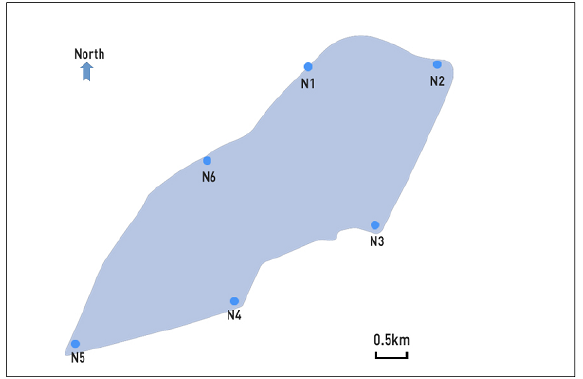
Figure 1. Distribution of sampling sites (N1–N6) in Nanhai Lake.